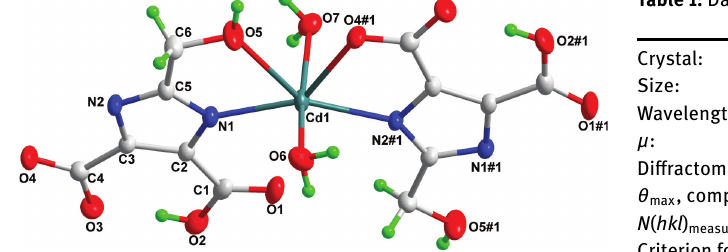
Table 1: Data collection and handling.